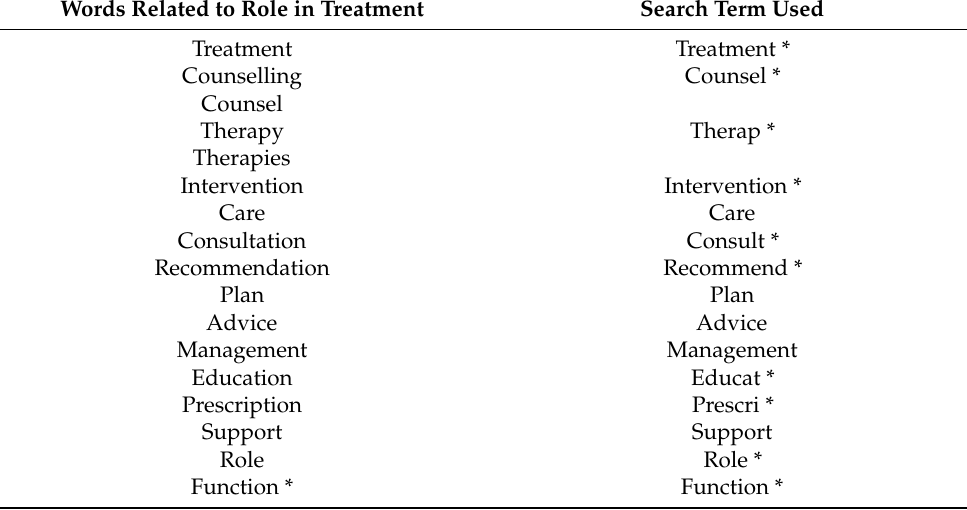
Table A1. Cont. Words Related to Role in Treatment